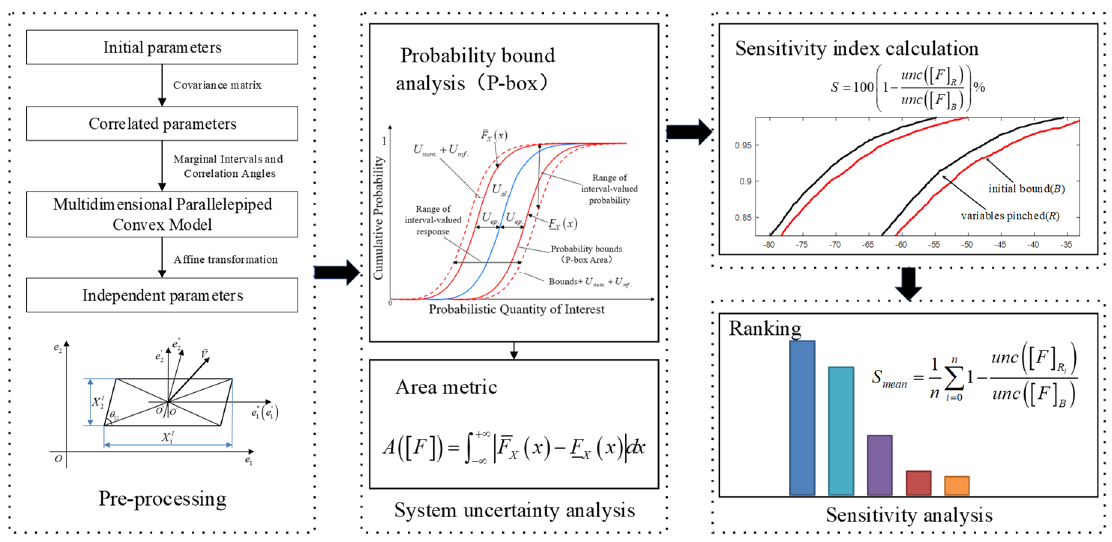
Figure 2. The total analysis process of the work [26].